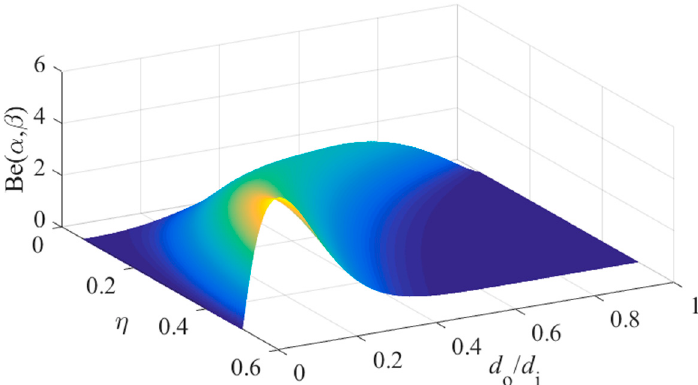
Figure 11. Beta distribution probability density function under different compression ratios.